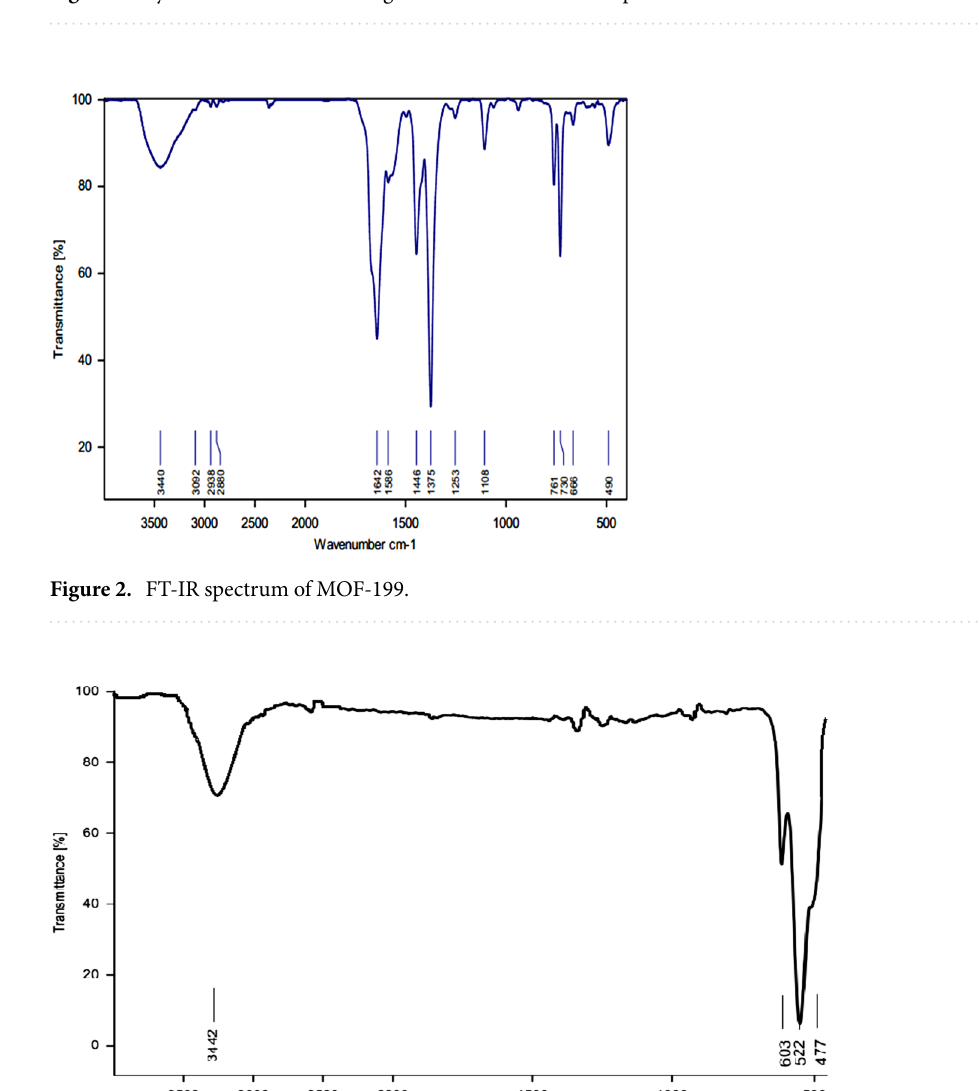
Figure 1. Synthesis of disulfides using MOF-199 and CuO nanoparticles.